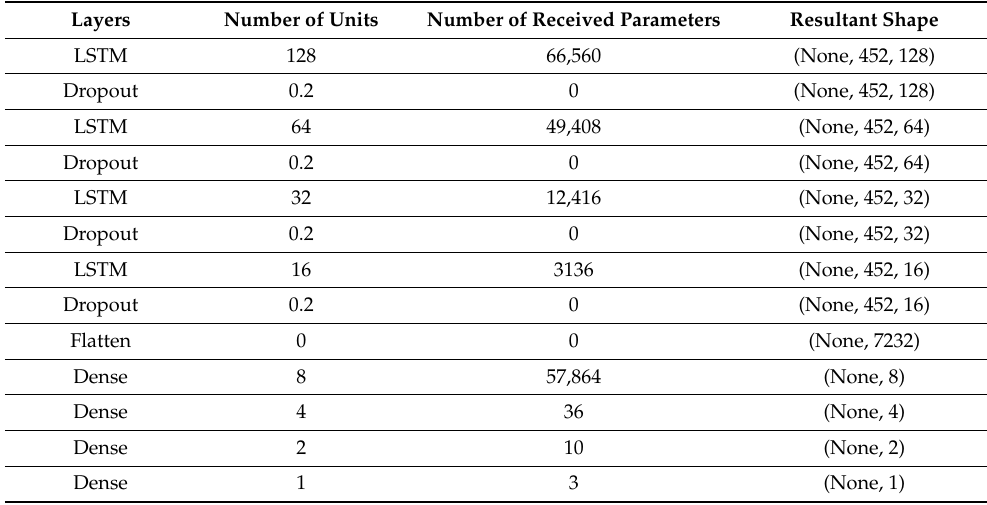
Table 4. Details of the LSTM